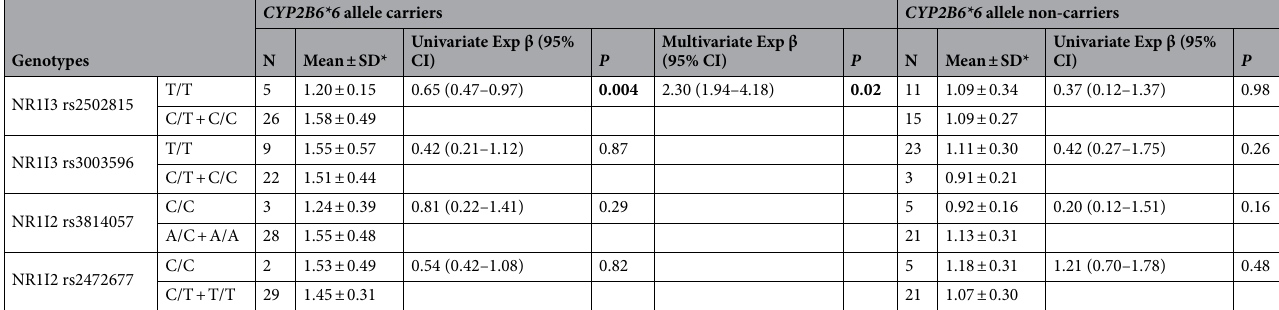
Table 6. Regression analysis for NR1I3 , NR1I2 variants on mean log EFV/8-OH-EFV metabolic ratios (MRs) at week-16 after initiation of EFV-based ART, stratified with CYP2B6*6 carrier status [ * —Mean of log plasma EFV Metabolic ratios and with the standard deviation (SD); ART—Antiretroviral therapy; CI—Confidence interval; EFV—Efavirenz; MR—Metabolic ratio; N—Number; P — P value]. Significant values are in